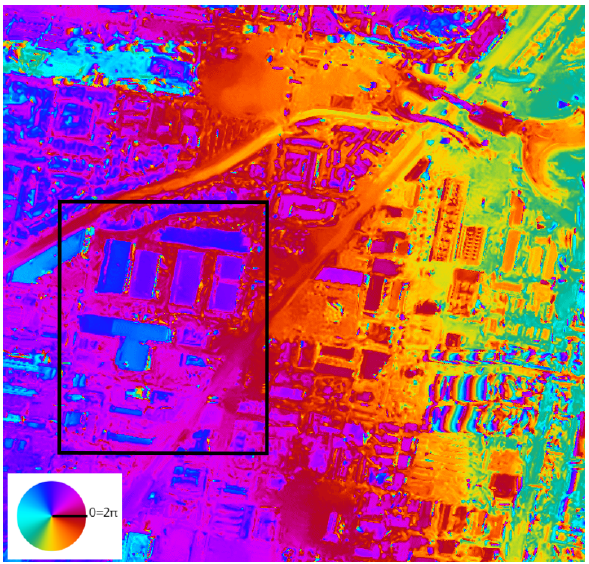
Figure 6: Interferometric phase of a portion of an acquisition over Las Vegas. In the black box the buildings under analysis.